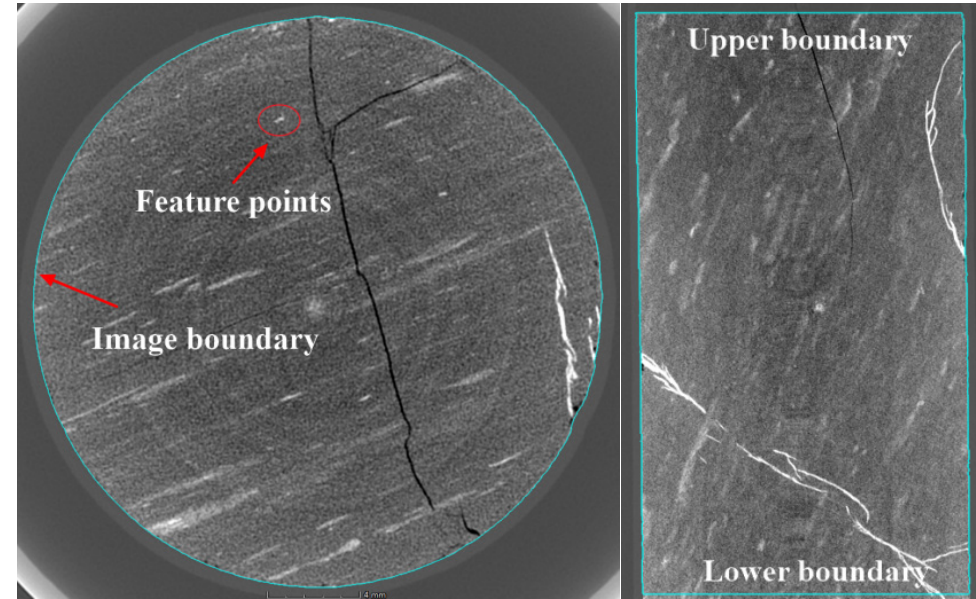
Figure 1. Boundary determination of 3D model.